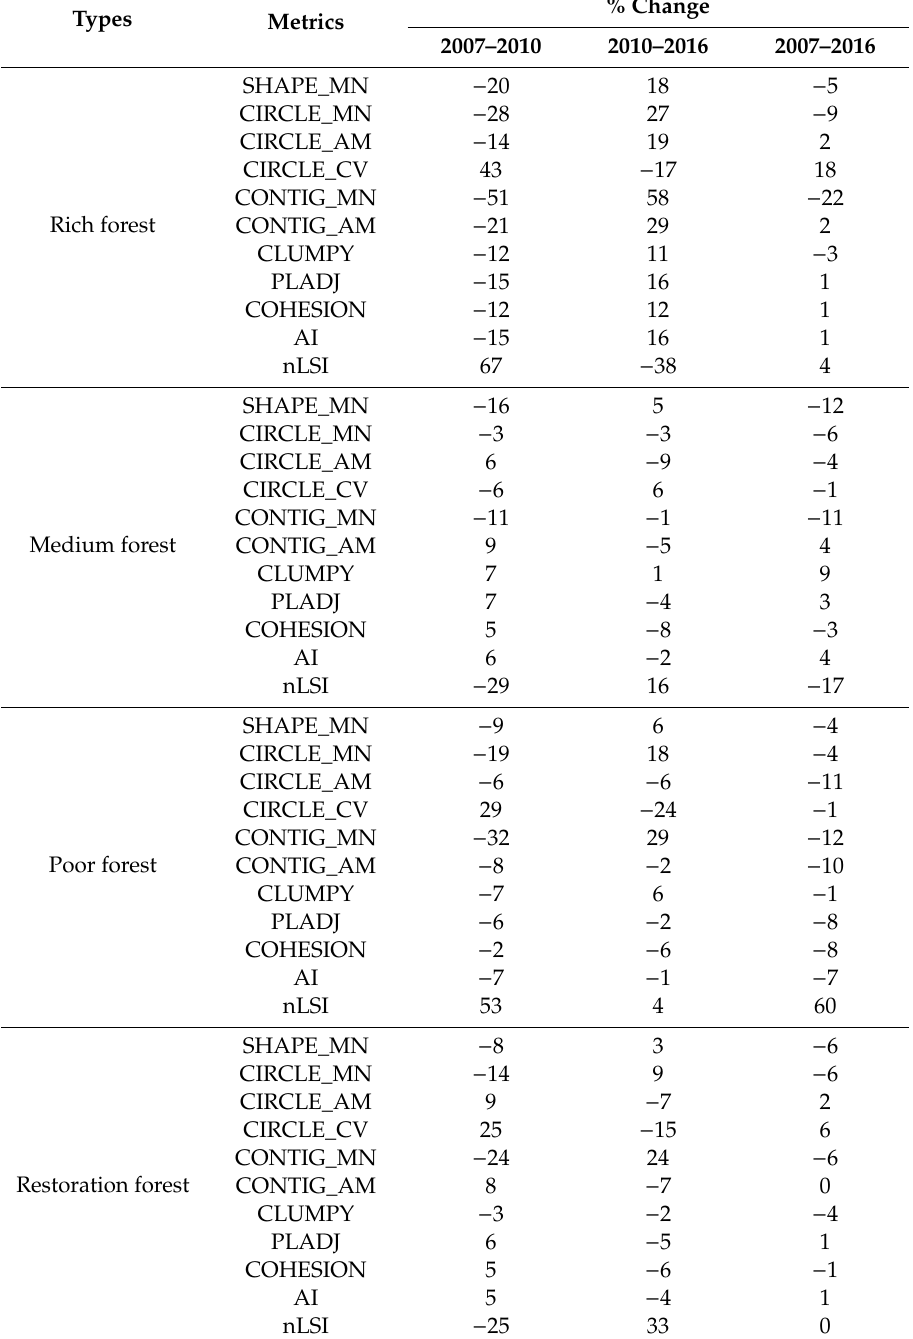
Table 4. Pattern metrics changes in the four forest types in class level